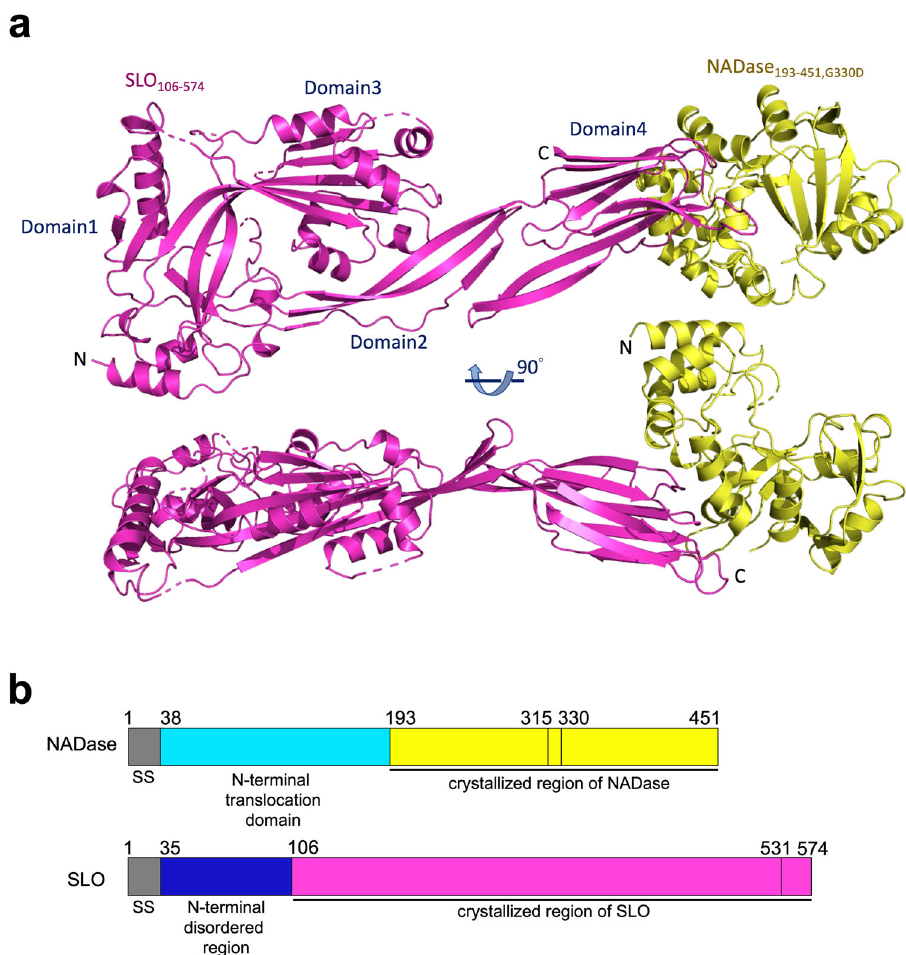
Fig. 1 Crystal structure of the NADase 193-451,G330D /SLO 106-574 complex. a Ribbon diagram of the crystal structure of the NADase 193-451,G330D /SLO 106-574 complex in two views related by a rotation of 90° about the horizontal axis. Yellow, NADase 193-451,G330D ; Magenta, SLO 106-574 . b Schematic diagrams of NADase and SLO: Grey, secretory signal (SS); Cyan, N-terminal translocation domain of NADase; Yellow, C-terminal enzymatic domain (crystallized region); Blue, N-terminal disordered/dynamic region of SLO; Magenta, domains 1 to 4 of SLO of NADase (crystallized region). The NADase mutant G330D lacks detectable NADase activity, while a key salt bridge is observed between NADase residue D315 and SLO residue